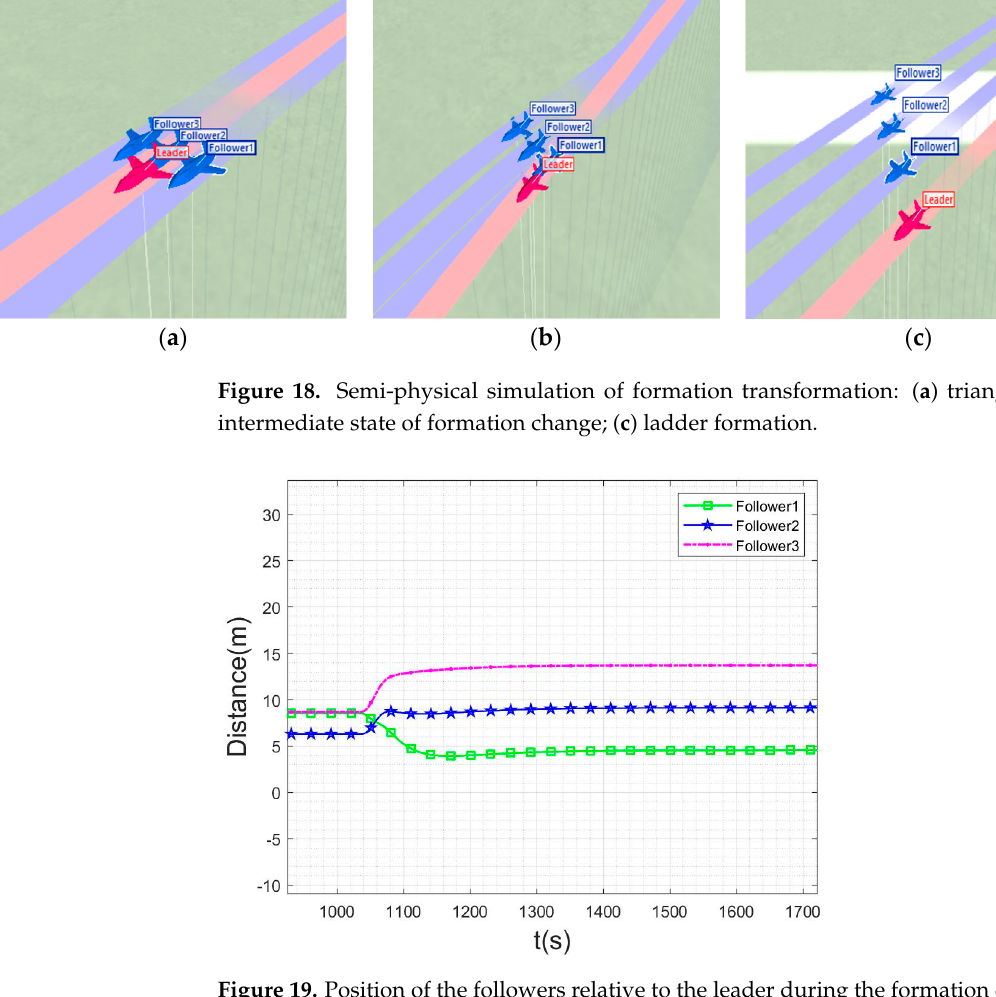
Figure 19. Position of the followers relative to the leader during the formation change. The formation change simulation also verifies the response characteristics of the guidance law to changes in the guidance target, in which the critical parameter is the change of heading angle ψ . In this hardware-in-the-loop simulation experiment, the leader and followers have the same heading and fly parallel in the triangular formation. After receiving the formation change command, the formation management module gen- erates a new route tracking point, and the guidance law directs the followers to the unique path tracking point, causing the heading angle to change. Figure 20 depicts the process of changing the formation’s heading angle. The heading angle of the followers changes rap-